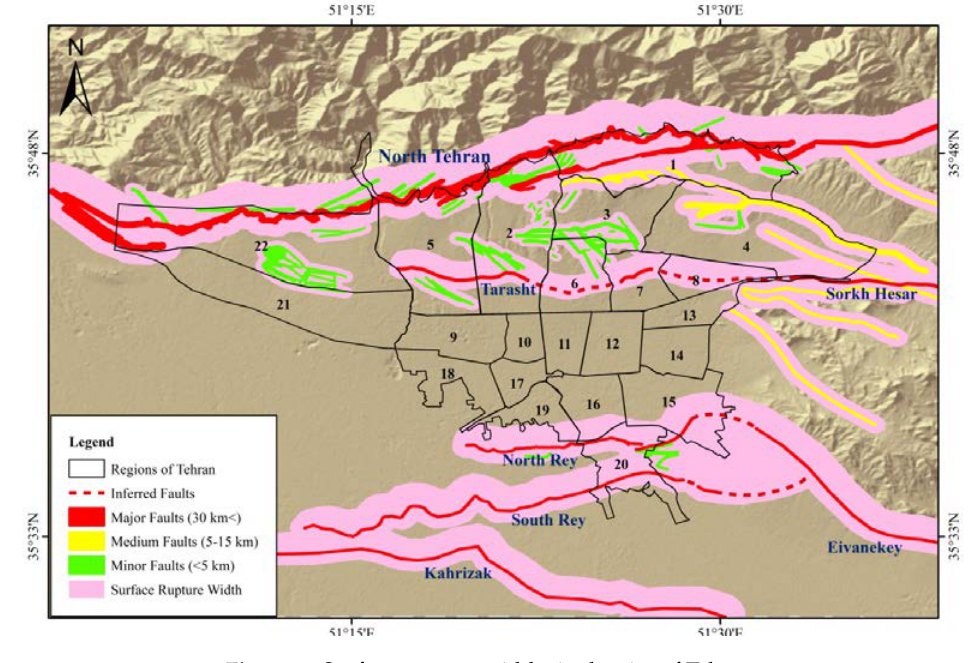
Table 2. Surface rupture width of faults within Tehran